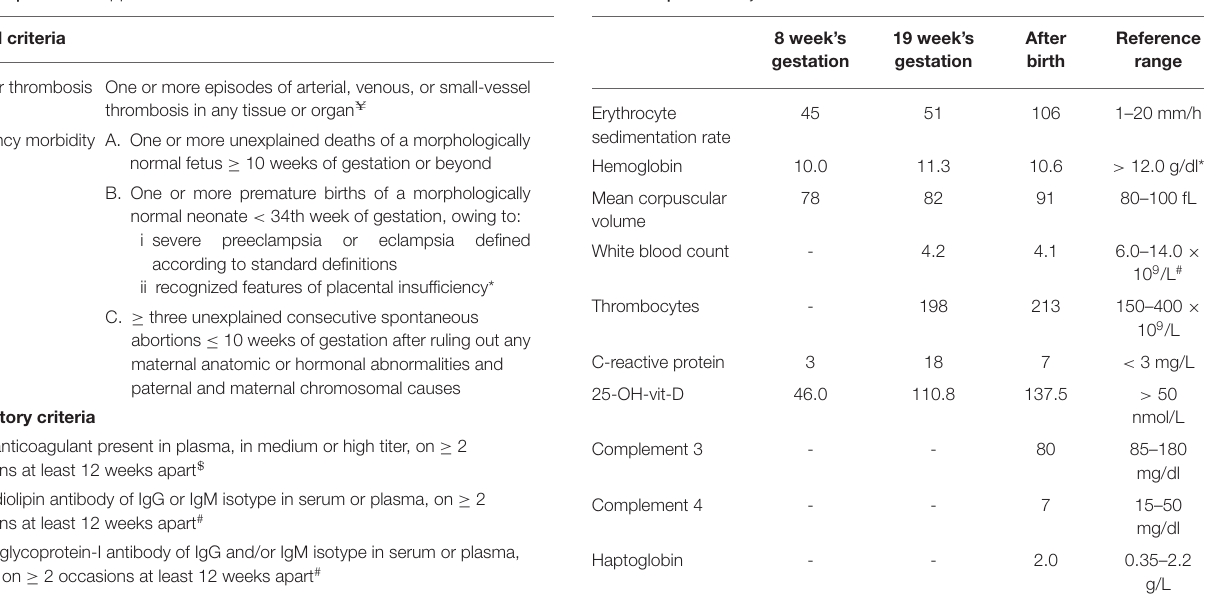
TABLE 1 | Revised Sapporo criteria for APS. TABLE 2 | Laboratory results